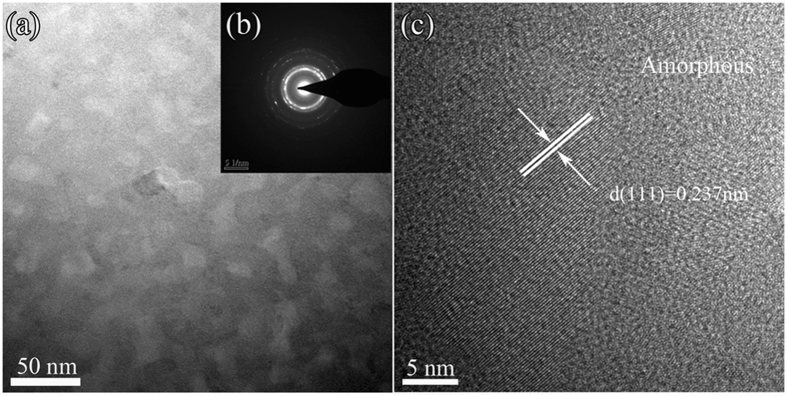
Bright-field TEM image (a), selected-area electron diffraction pattern (b) and HREM image (c) of the initially fully glassy alloy Al84Y9Ni4Co1.5Fe0.5Pd1 annealed for 300 s at 620 K corresponding to the second exothermic peak (Fig. 1).